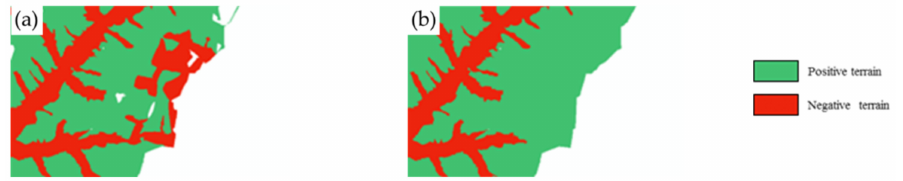
Figure 4. Slope’s influence on the positive and negative terrain classification results: ( a ) represents the classification map of positive and negative terrain; ( b ) represents the results after slope correction.